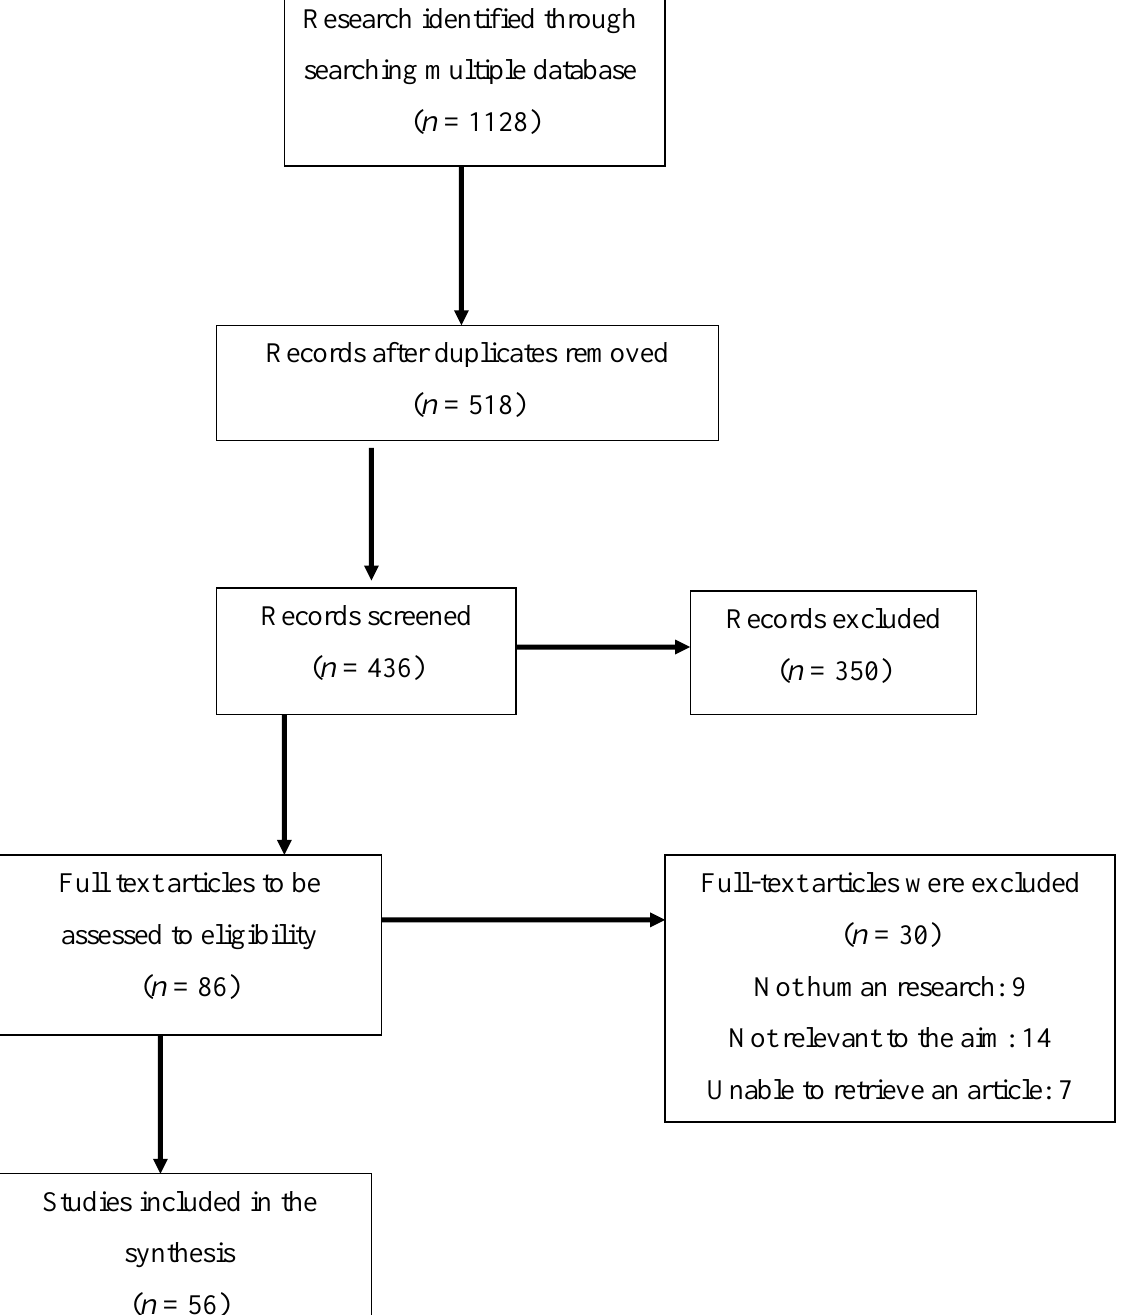
Figure 2. Flow chart of the proceedings in the selection of sources.